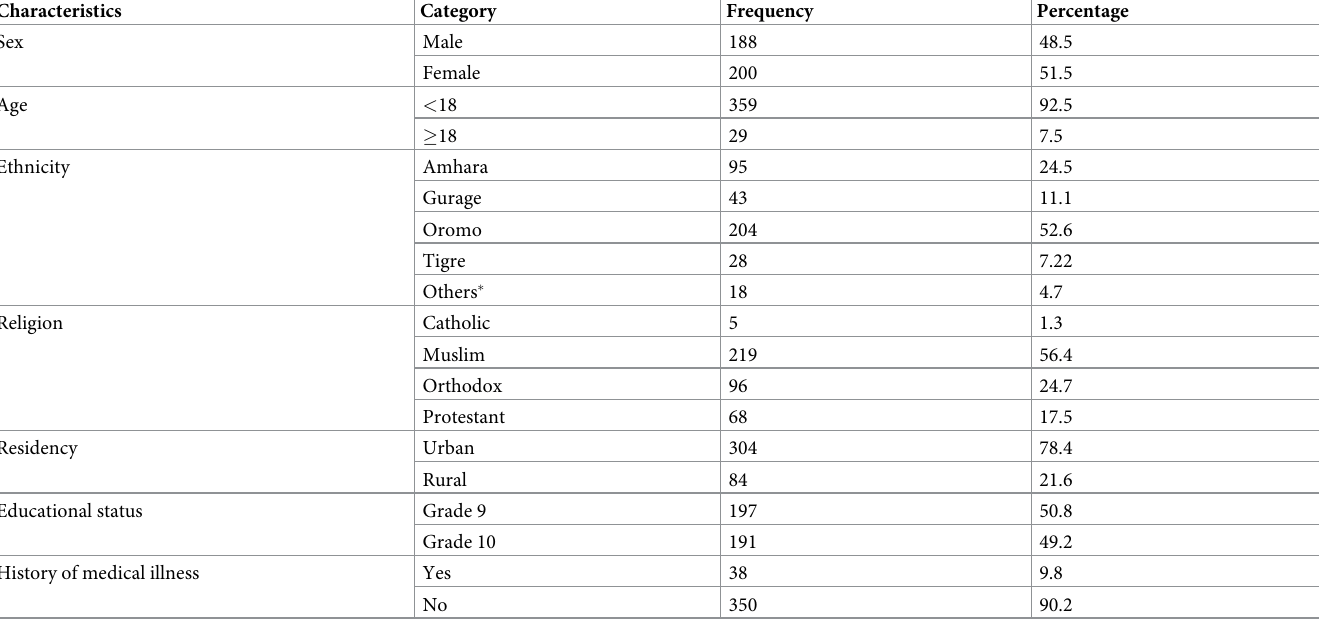
Table 1. Socio-demographic characteristics of students of Jimma high school, Jimma town southwest Ethiopia, 2021 (N = 388). Characteristics